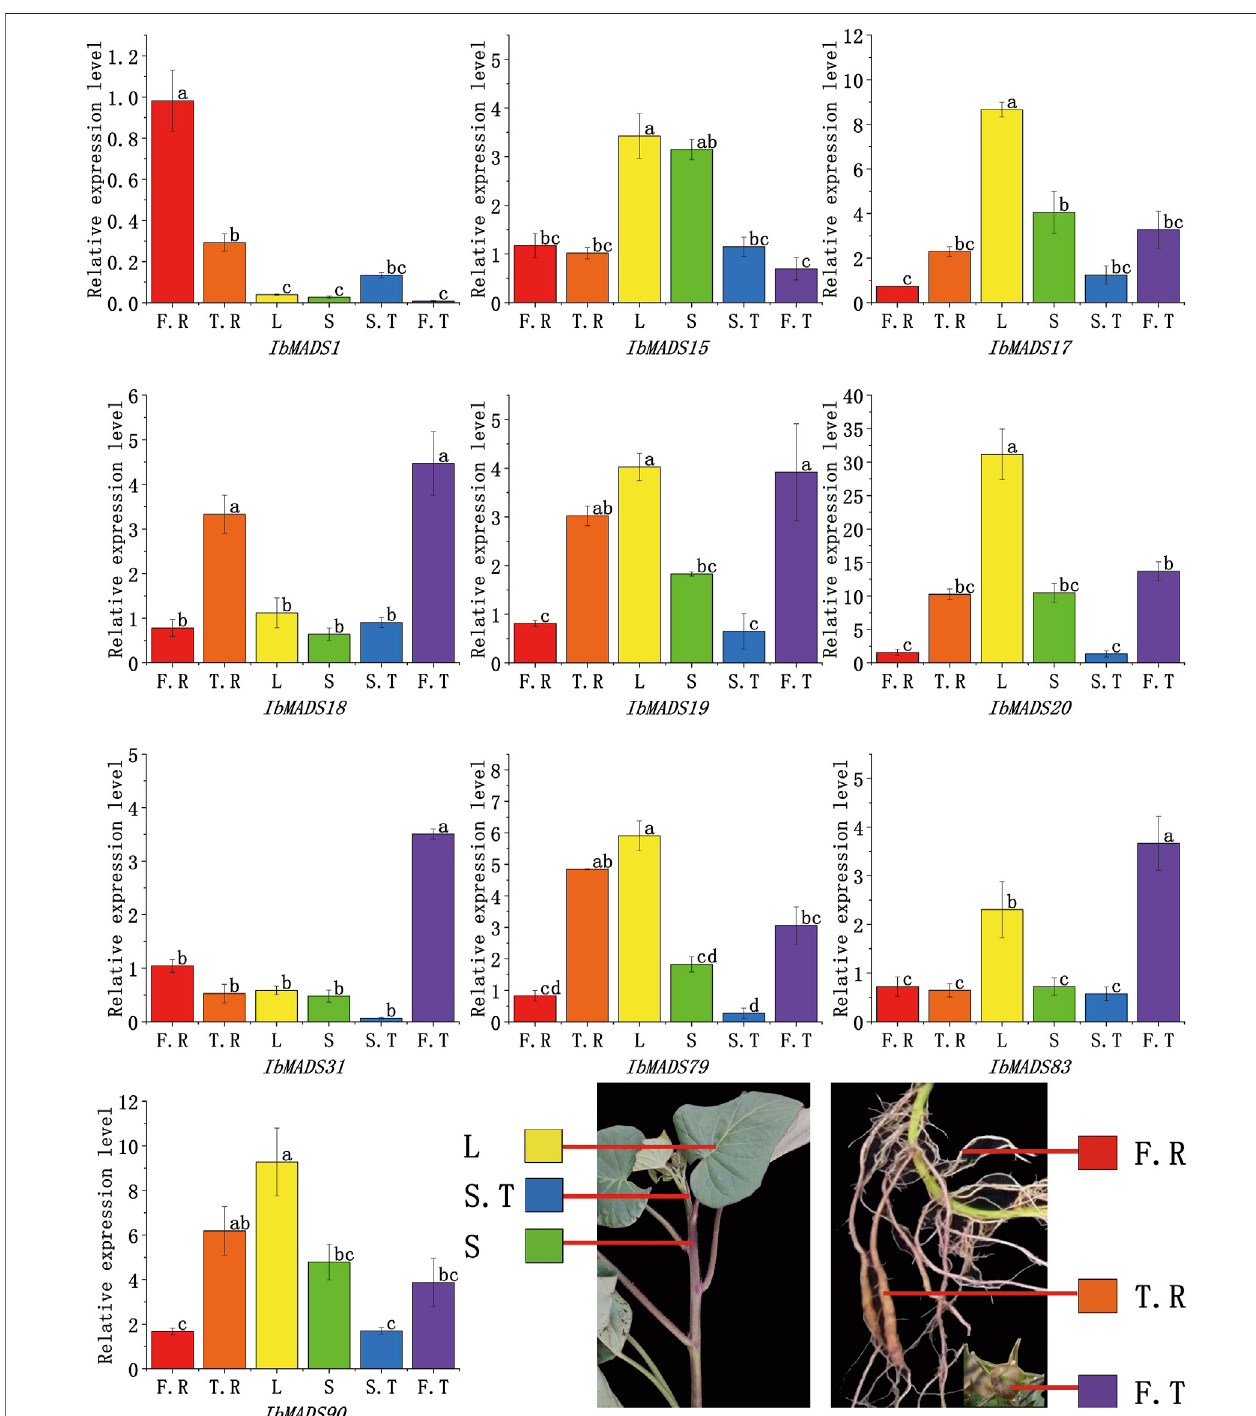
FIGURE 8 | The gene expression levels of some MADS-box genes in different tissues of sweet